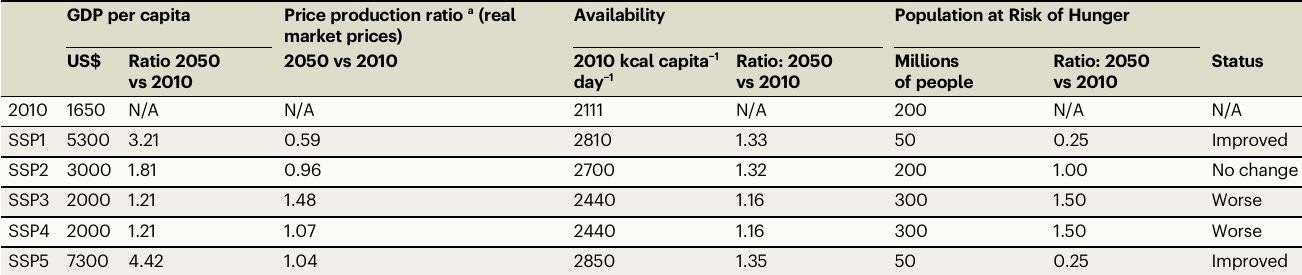
Table 1 | Projected food security parameters for Sub-Saharan Africa at different SSPs for the 21st Century 5